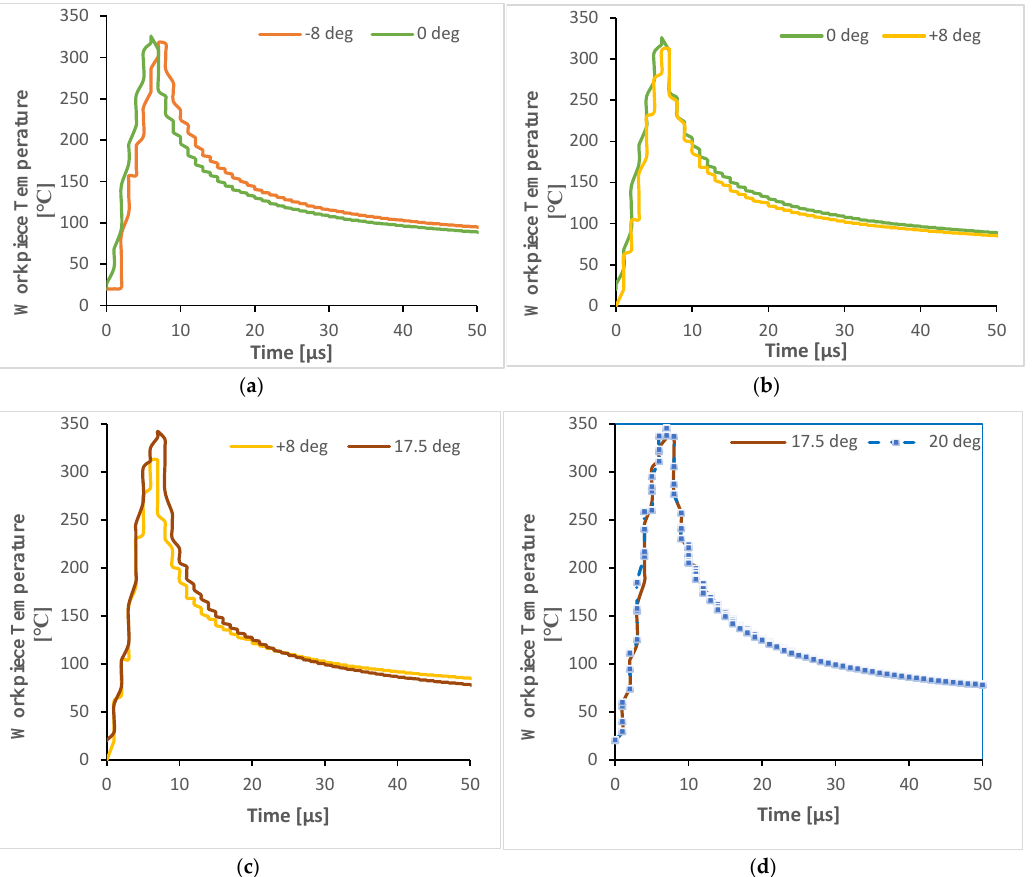
angle are shown in Figure 14. The results were obtained by tracking a fixed point P1 on